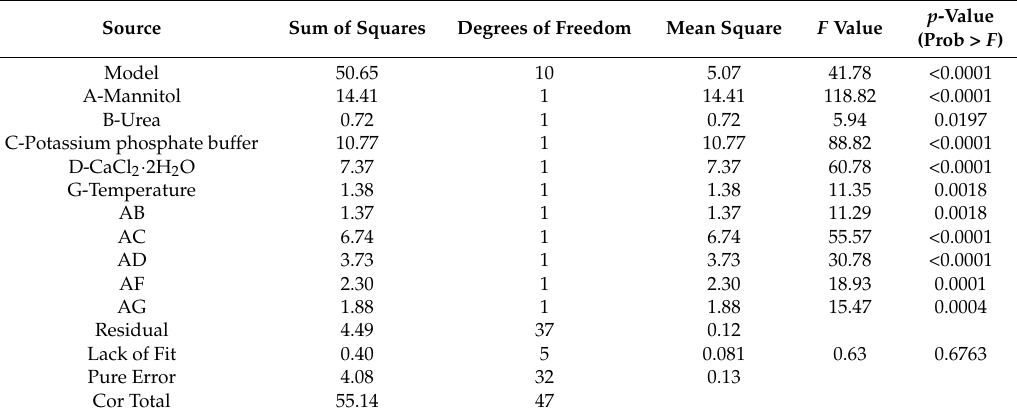
Table 5. ANOVA analysis for the reduced regression model of biomass production.